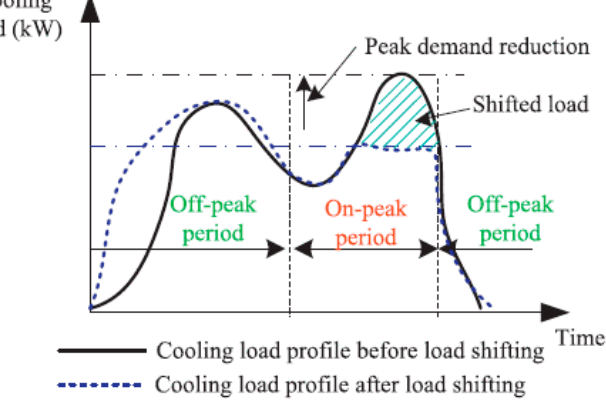
Figure 7. Overall view of a typical peak load shifting [94].